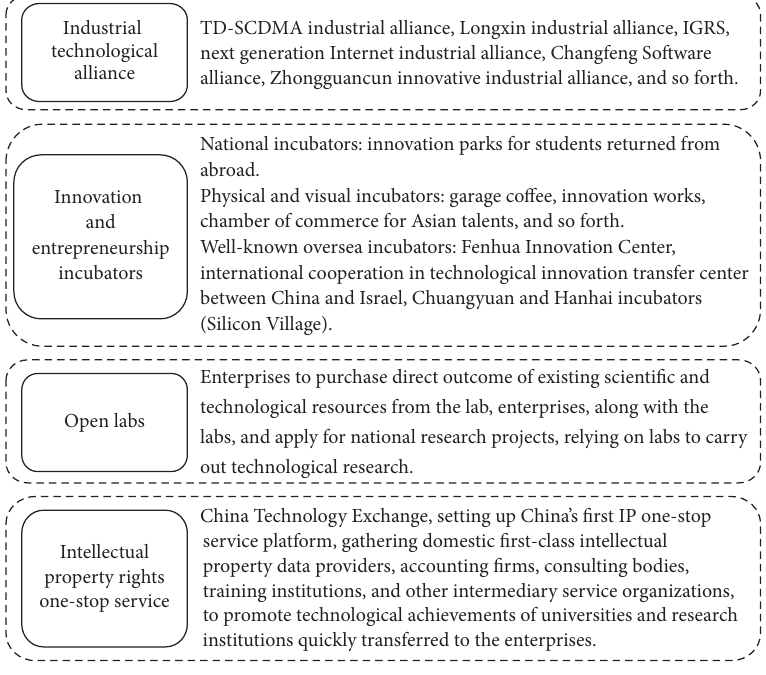
Figure 10: Typical modes of cooperation innovation of